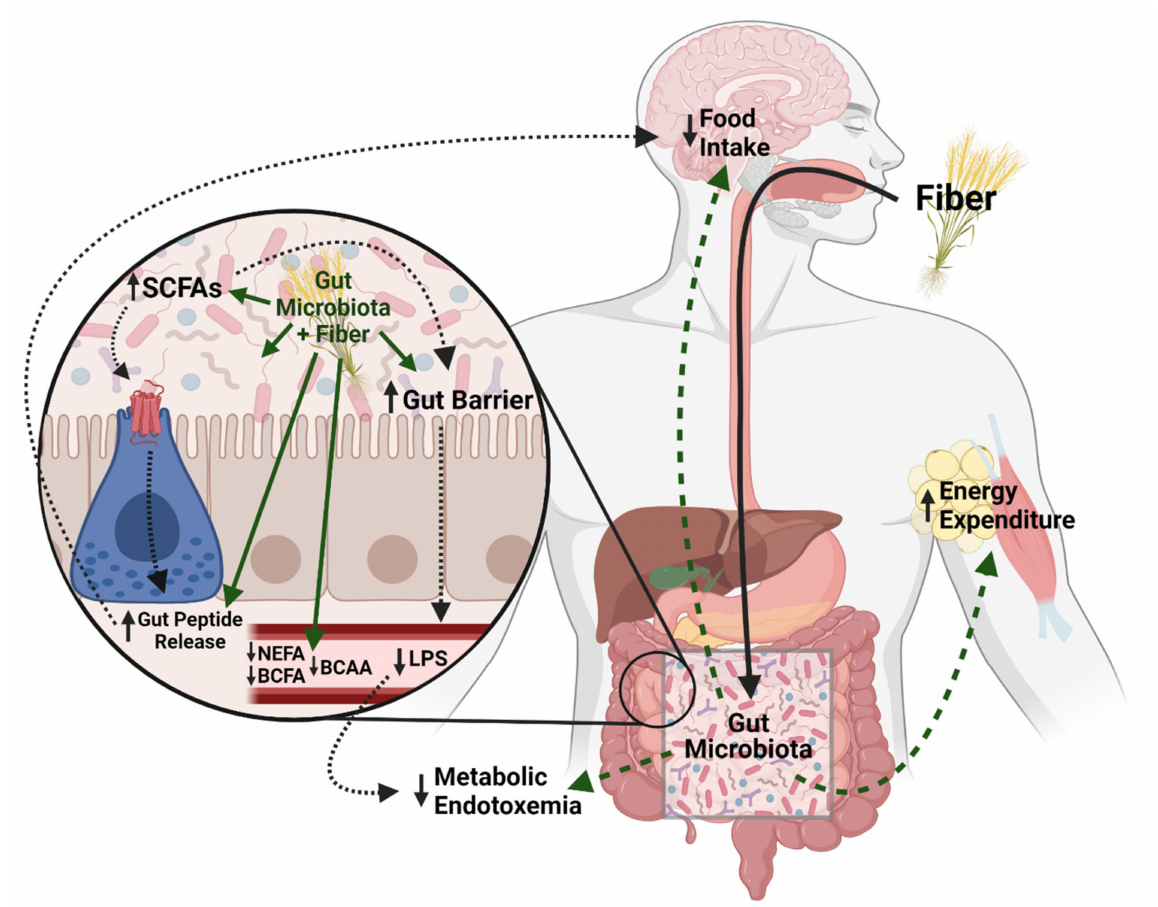
Figure 1. Potential Mechanisms for the beneficial effects of dietary fiber on metabolic homeostasis. Dietary fiber can shift the gut microbiota to promote gut barrier health and decrease circulating lipopolysaccharide (LPS) and subsequently lower metabolic endotoxemia. The gut microbiota also breaks down fiber into short chain fatty acids that can induce gut peptides that influence metabolic homeostasis, as well as impact the gut barrier. Additionally, dietary fiber can lower circulating non-esterified fatty acids NEFA), branched-chain fatty acids (BCFA), branched-chain amino acids (BCAA) which are associated with metabolic dysregulation. Dietary fiber may also increase energy expenditure although the mechanisms are not well understood. Created with BioRender.com (accessed on 9 August